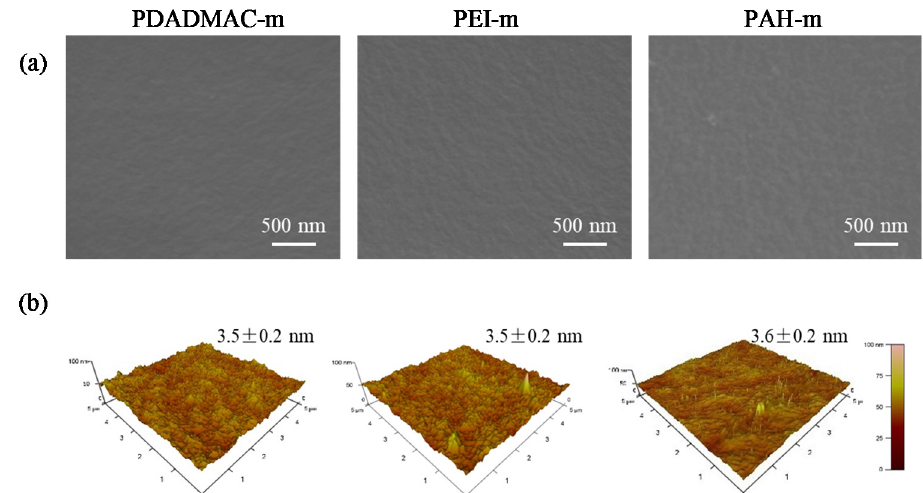
Figure 8. Comparison of the geometrical characteristics of the PAN-A substrates modified with the deposition of PDADMAC, PEI, and PAH via ( a ) SEM and ( b ) AFM. The SEM images demonstrate both the top views of the modified PAN-A substrates; the AFM images are displayed along with the associated roughness values in terms of the RMS.